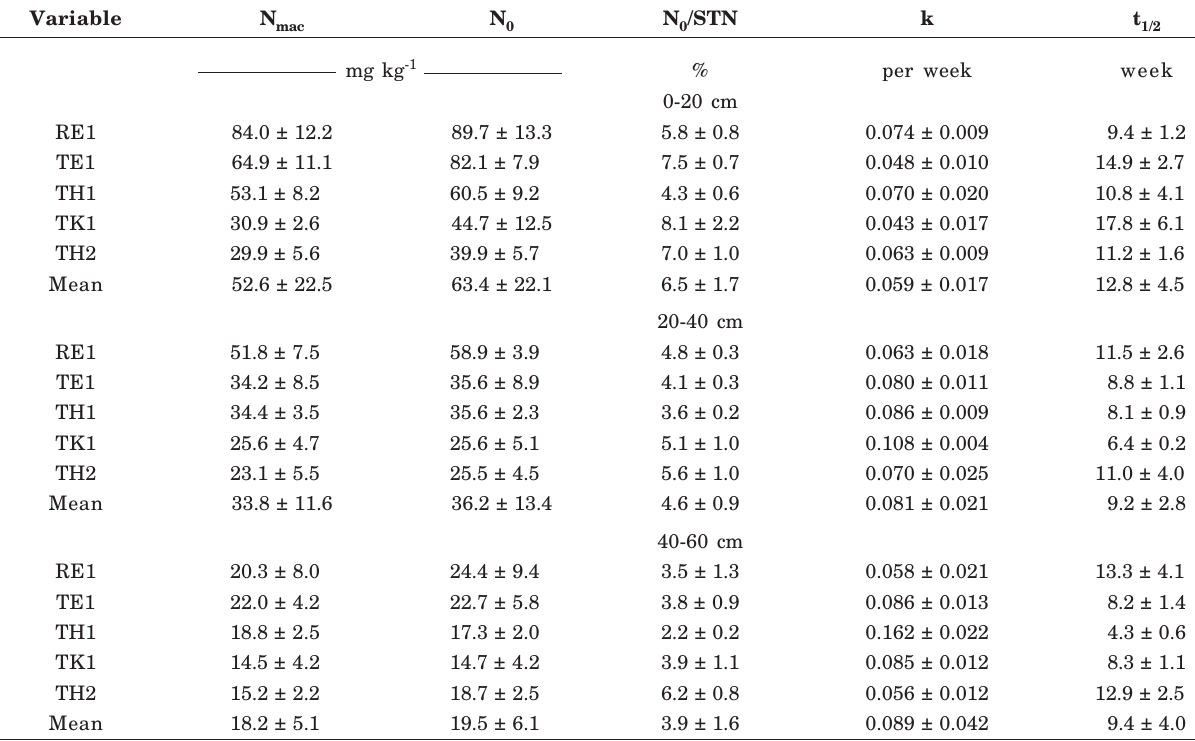
Table 2. Mineralized N in soil samples subjected to long-term aerobic incubation (N mac ), N mineralization potential (N 0 ), percentage ratio of mineralizable N to total soil N (N 0 /N total ), mineralization constant